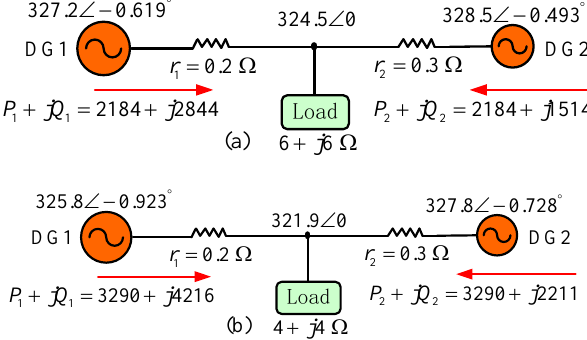
Figure 6. Simulation parameters and results in Case A: ( a ) during 0–0.7 s and 1.4–2 s; and ( b ) during 0.7–1.4 s.